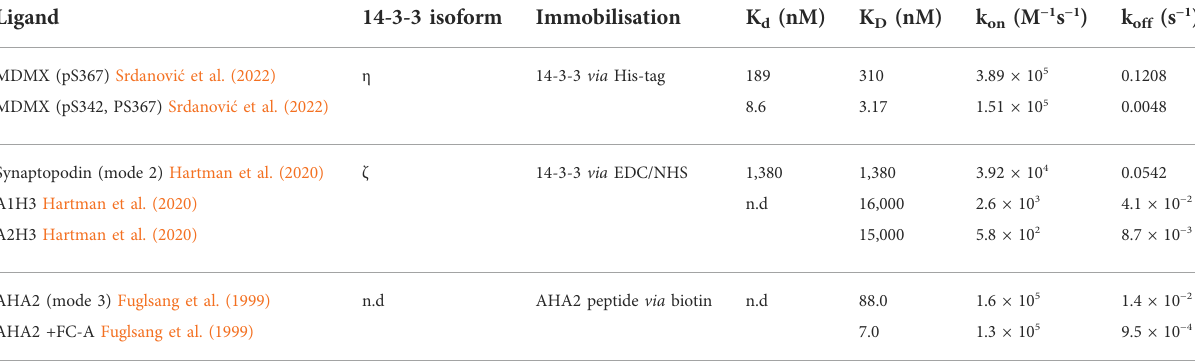
TABLE 1 Examples of quantitative SPR analysis of 14-3-3